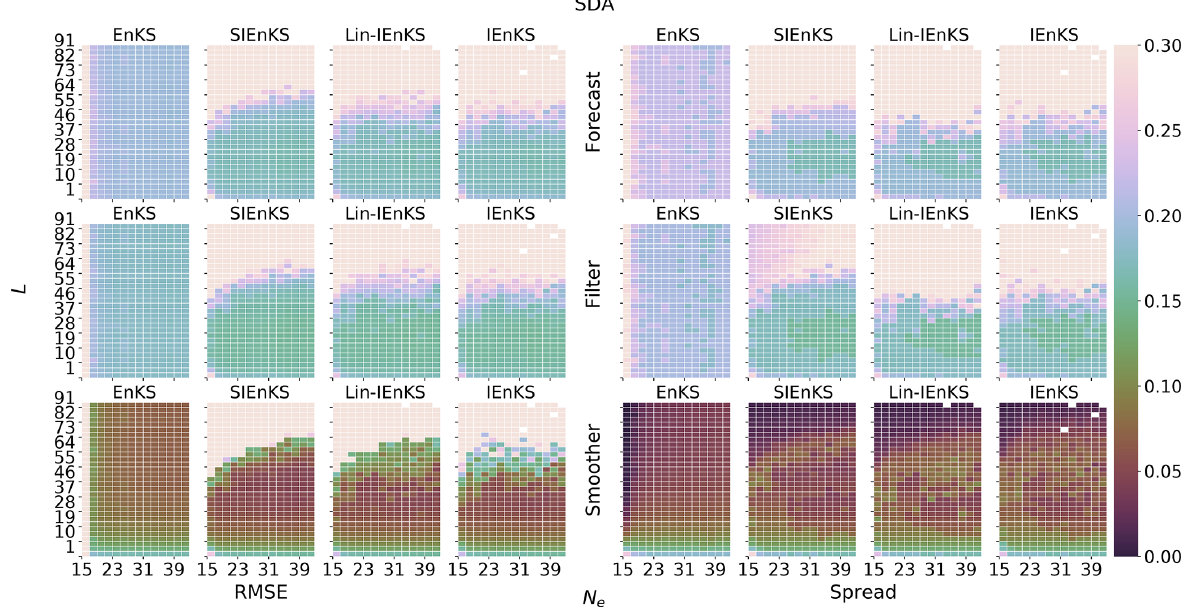
Figure 6. The lag length L is shown on the vertical axis, and the ensemble size N e is shown on the horizontal axis. SDA, tuned inflation, shift S = 1, linear observations, and (cid:49)t = 0 . 05 are also indicated.